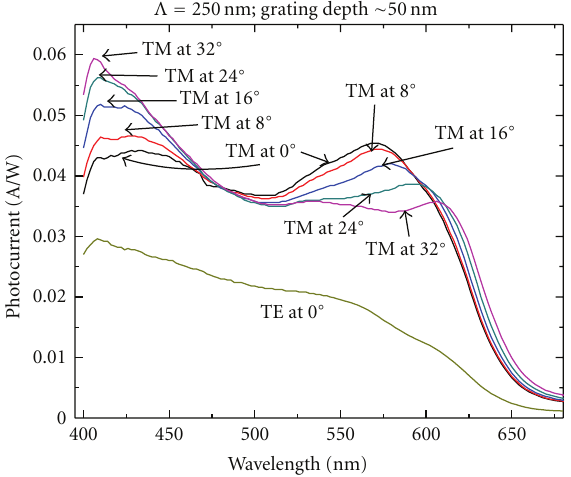
Figure 7: The TE and TM photocurrent responses of the P3HT- PCBM layer as a function of wavelength with Λ = 250nm and at various incidence angles.